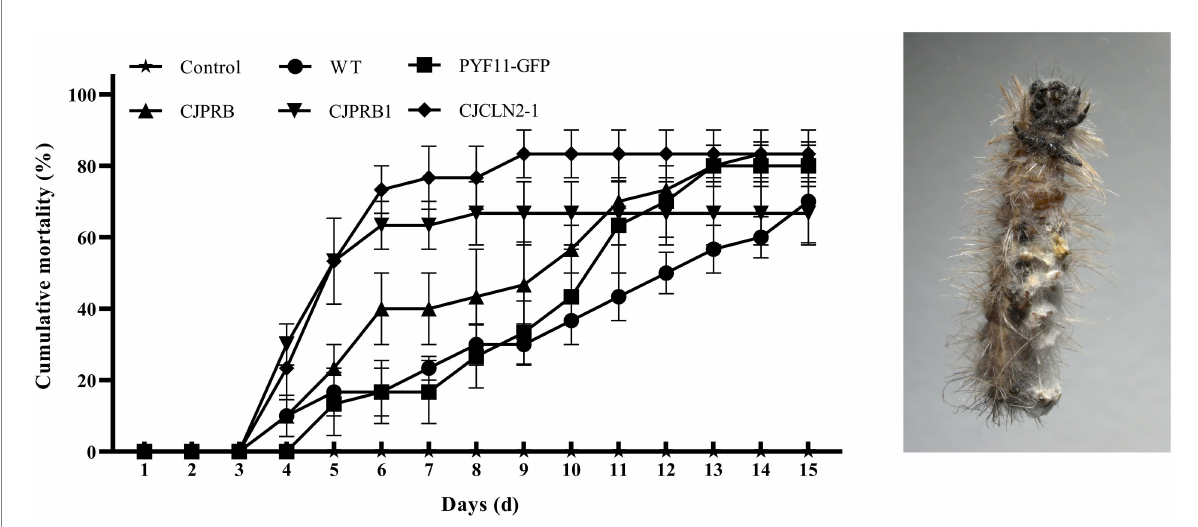
FIGURE 4 Cumulative mortality (mean ± SE) of H . cunea larvae in response to different types of C . javanica BE01 strains over 15 days. Cumulative mortality (mean ± SE) of H . cunea larvae (left) and dead larvae covered with mycelia (right).